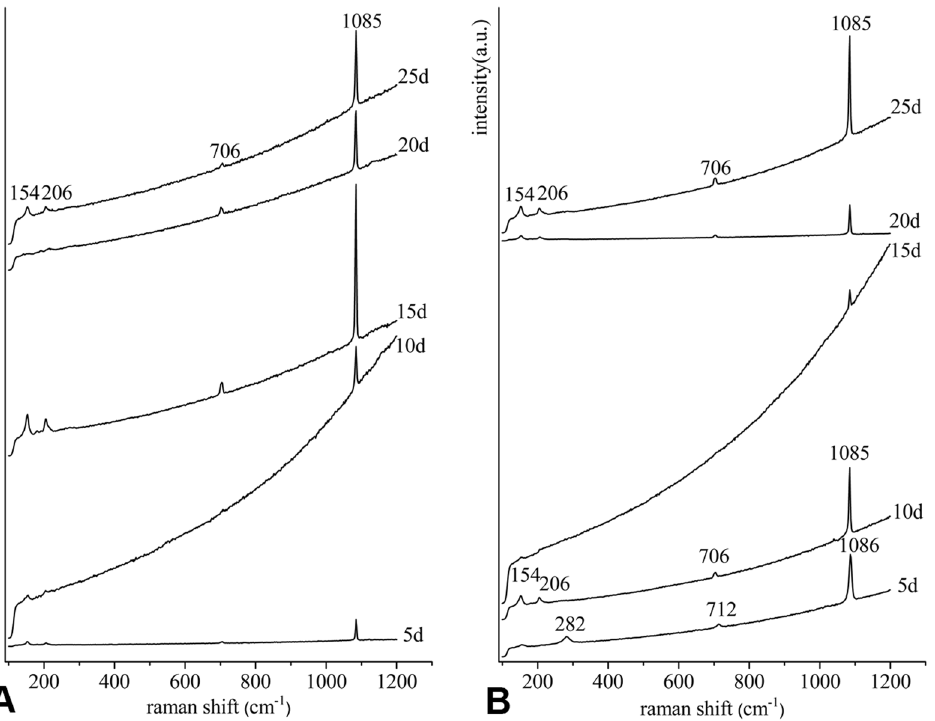
Figure 2. Raman spectra of the crystals deposited on the surface. (A) in the inner-shell film system, (B) in the film-free system. The characteristic peaks of calcite are at 282, 712 and 1086 cm 2 1 (5d in B), and those of aragonite are at 154, 206, 706 and 1085 cm 2 1 .